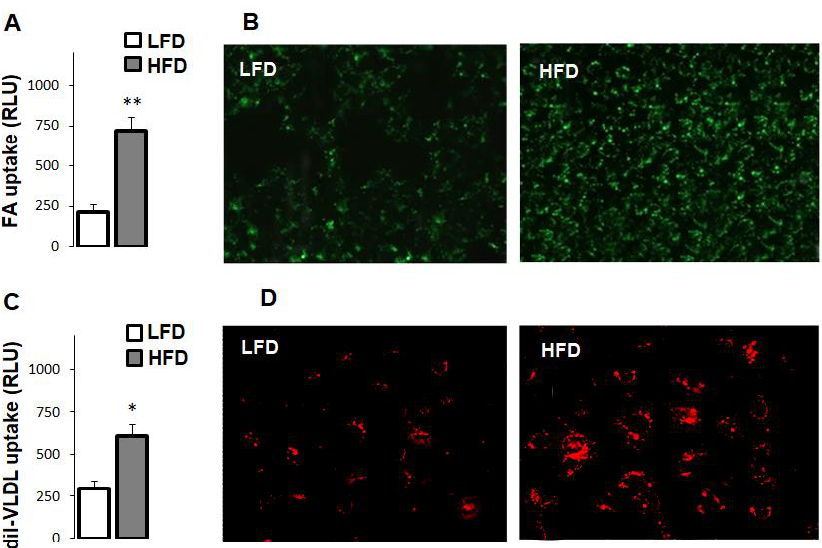
Figure 2. Effects of high-fat diet on fatty acid and VLDL uptake. Uptake of fatty acids ( A ) and VLDL ( C ) were measured in isolated hepatocytes (6 mice per group) using Bodipy C16 and diI-VLDL, as described in Methods. Statistical difference was assessed with unpaired t -test with ** p < 0.01 and * p < 0.05. Microscopic images of hepatocytes incubated with Bodipy C16 ( B ) and diI VLDL ( D ) showed intracellular